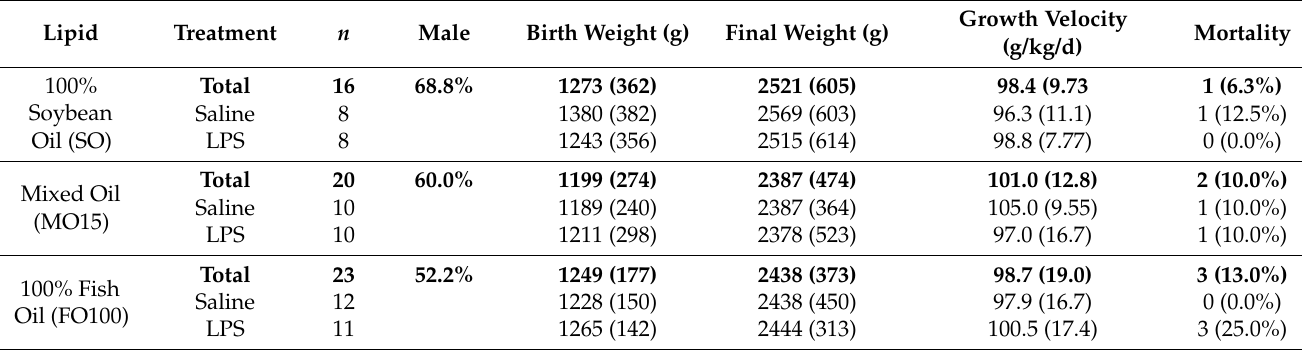
Table 1. Piglet cohort characteristics by lipid groups.